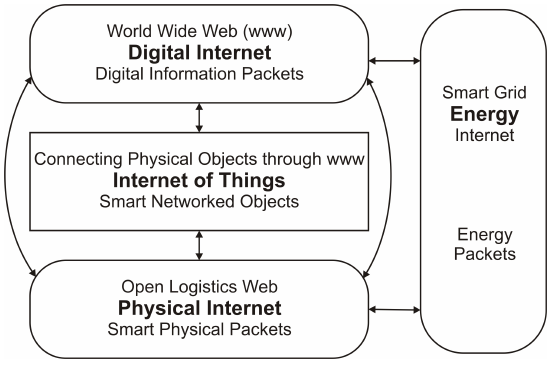
Figure 3: Universal digital and physical interconnectivity in PI, adapted from